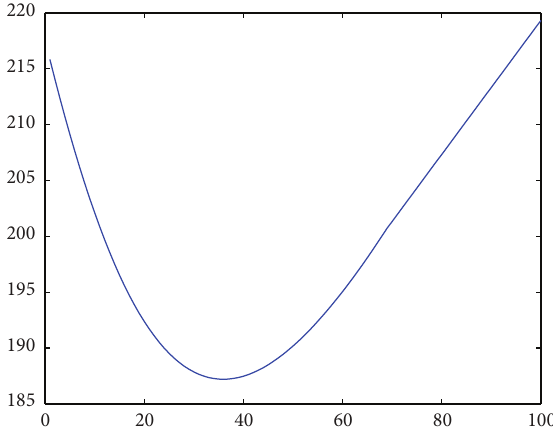
Figure 3: The expected total cost with different batch